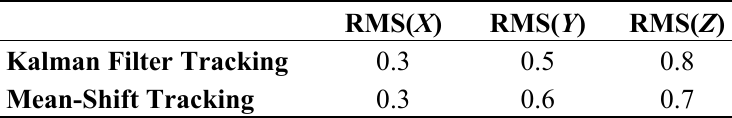
Table 2. Evaluation of the tracking accuracy in cm.